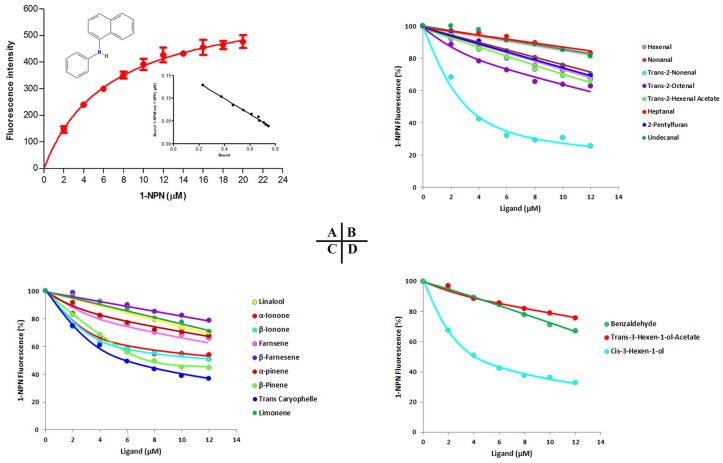
Binding of 1-NPN and various ligands to McinOBP1.(A) Binding curves and relative Scatchard plot (insert) of N-phenyl-1-naphthylamine (1-NPN) and McinOBP1 protein. Two μM solutions of protein was titrated with 1 μM solution of 1-NPN in methanol to final concentrations of 2–20 μM. (B) Competitive binding affinities of McinOBP1-wt to different aldehyde ligands. (C) Binding affinities of various terpenoids to McinOBP1-wt and (D) Affinities of McinOBP1-wt to aliphatic alcohol and others.